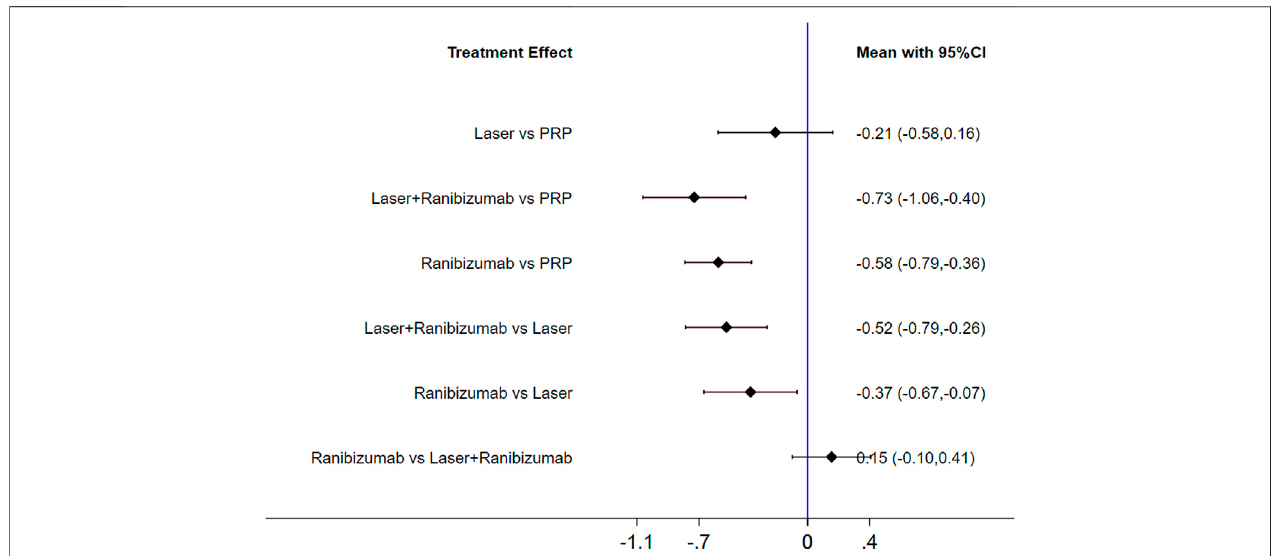
FIGURE 6 | Forest plots for head-to-head comparisons of SMD of central retinal thickness. Horizontal lines indicate the range of 95% CI.